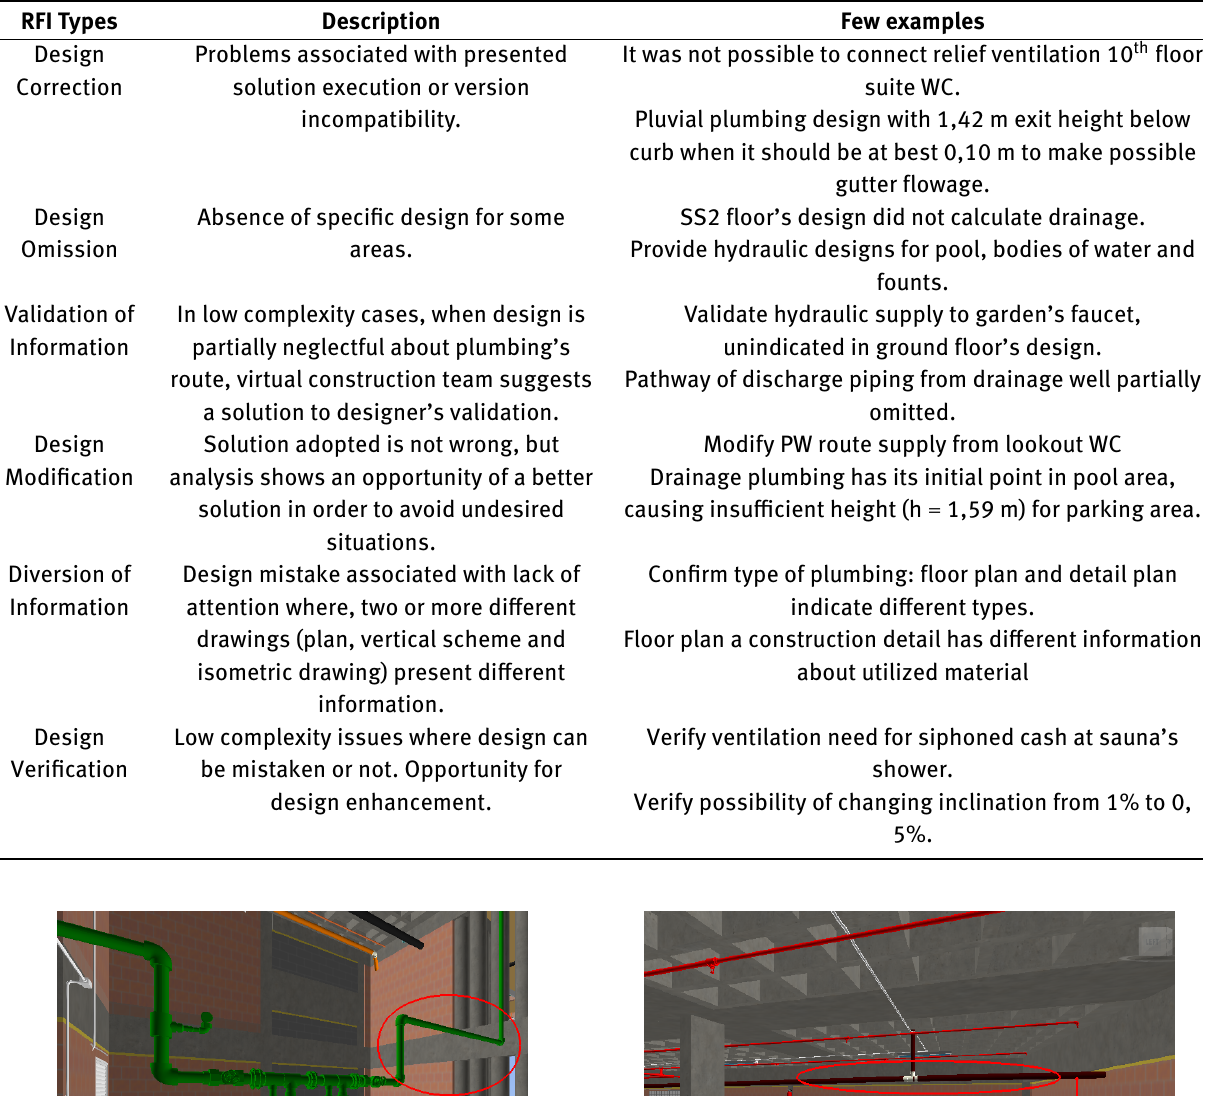
Table 1: RFI classification.